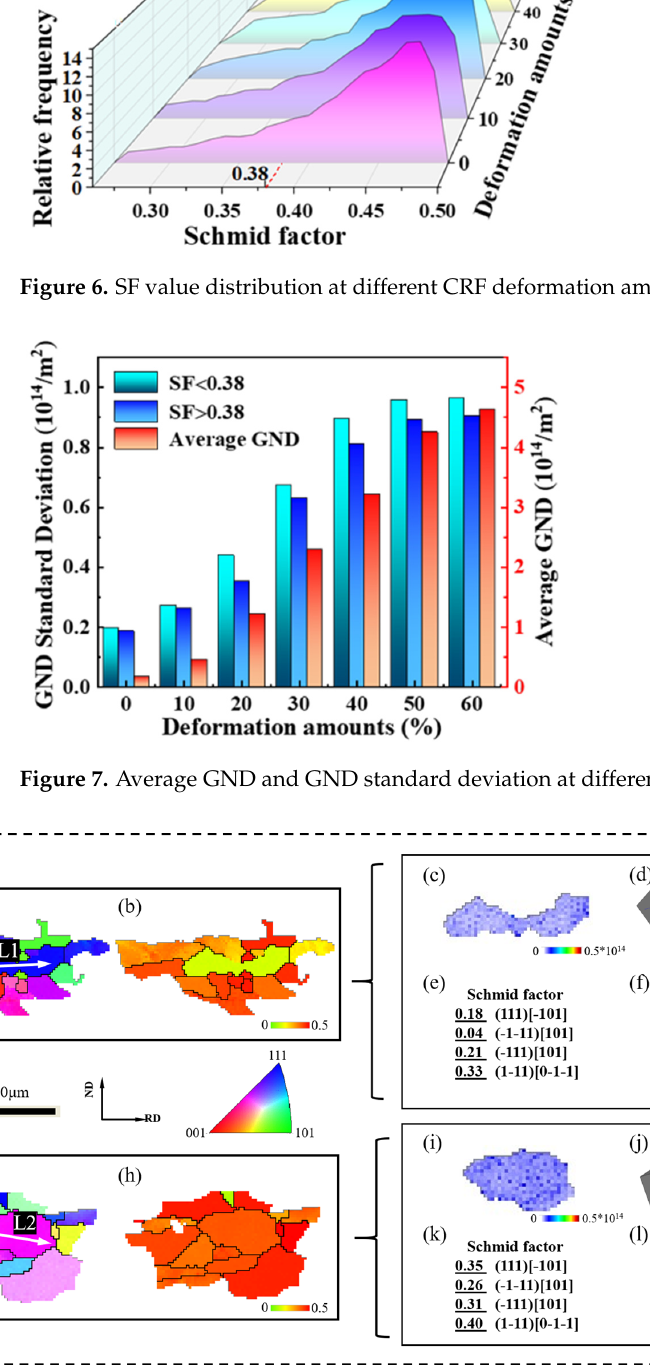
Figure 9. EBSD analysis of local area under CRF-20% conditions: ( a ) IPF map of large SF grains, ( b ) SF map of large SF grains, ( c ) GND map of large SF grains, ( d ) grain orientation of large SF grains, ( e ) SF value of large SF grains, and ( f ) PFs of large SF grains; ( g ) IPF map of small SF grains, ( h ) SF map of small SF grains, ( i ) GND map of small SF grains, ( j ) grain orientation of small SF grains, ( k ) SF value of small SF grains, and ( l ) PF of small SF grains.